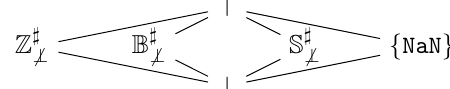
Figure 6. Coalesced sum abstract domain for µ JS